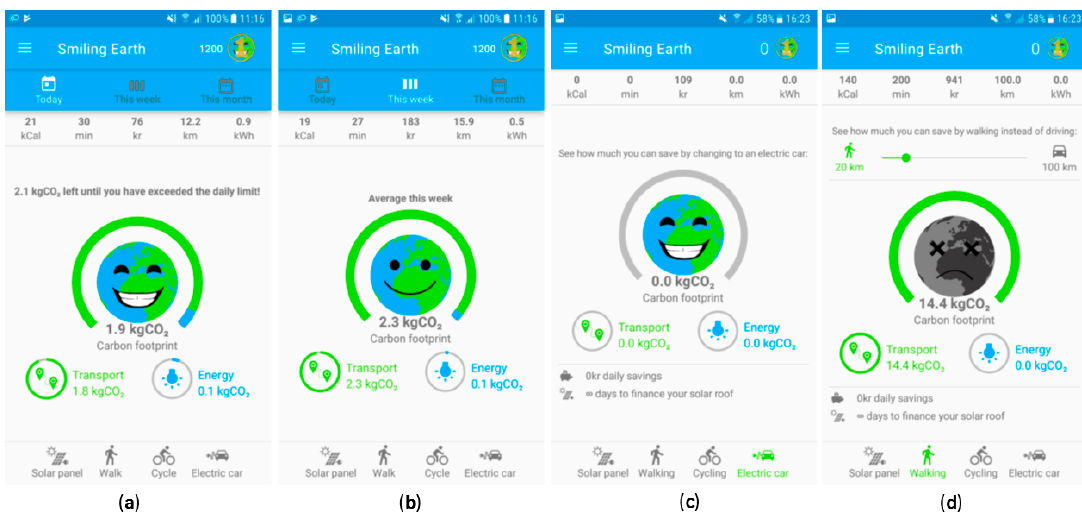
Figure 4. Smiling Earth concept, Graphical User Interface (GUI) and the Earth metaphor. ( a ) shows a very happy earth due to low CO 2 emissions; ( b ) shows a less happy face as the CO 2 emissions increase; ( c ) shows a happy earth due to low CO 2 emissions from an electrical vehicle and ( d ) shows a very miserable earth due to a high level of CO 2